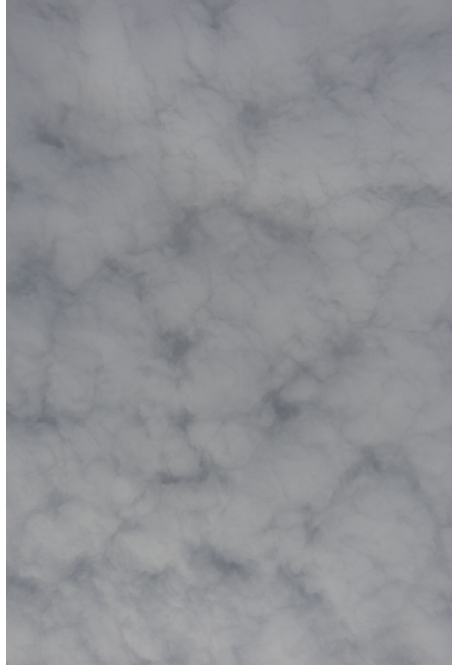
Fig. 7. Exemplary single camera image (09:41:23 UTC) of stratocumulus observations used to analyze averaging requirements.